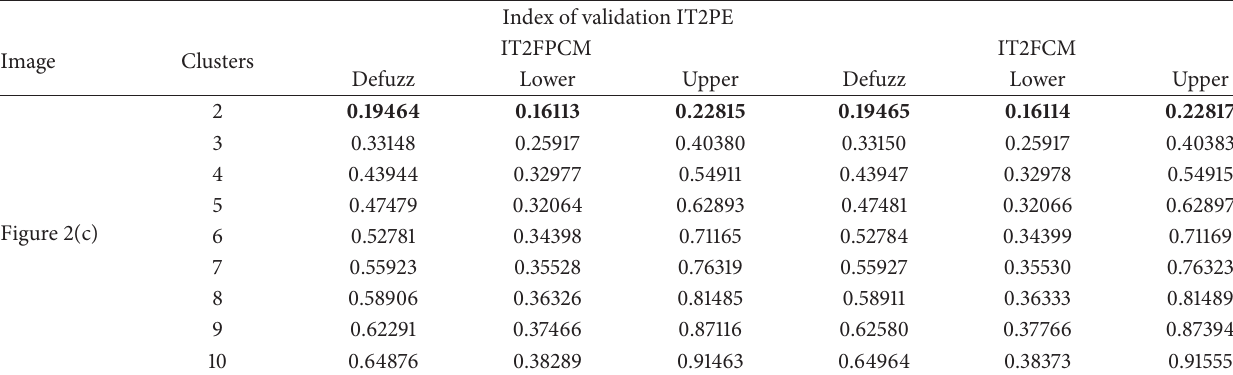
Table 34: Results of the IT2PE validation index to the clustering of image shown in Figure 2(c) using IT2FPCM and IT2FCM algorithm with 𝑚 = [1.5, 2.5] and 𝜂 = [1.5, 2.5] as parameters.